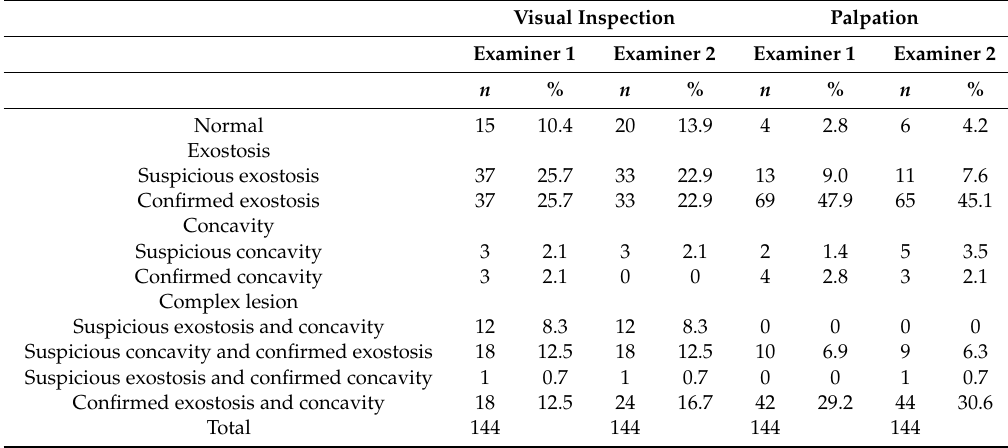
Table 1. Distribution of categories of lesions in nasal bones ( n and %) as detected by two examiners conducting visual inspection and palpation.